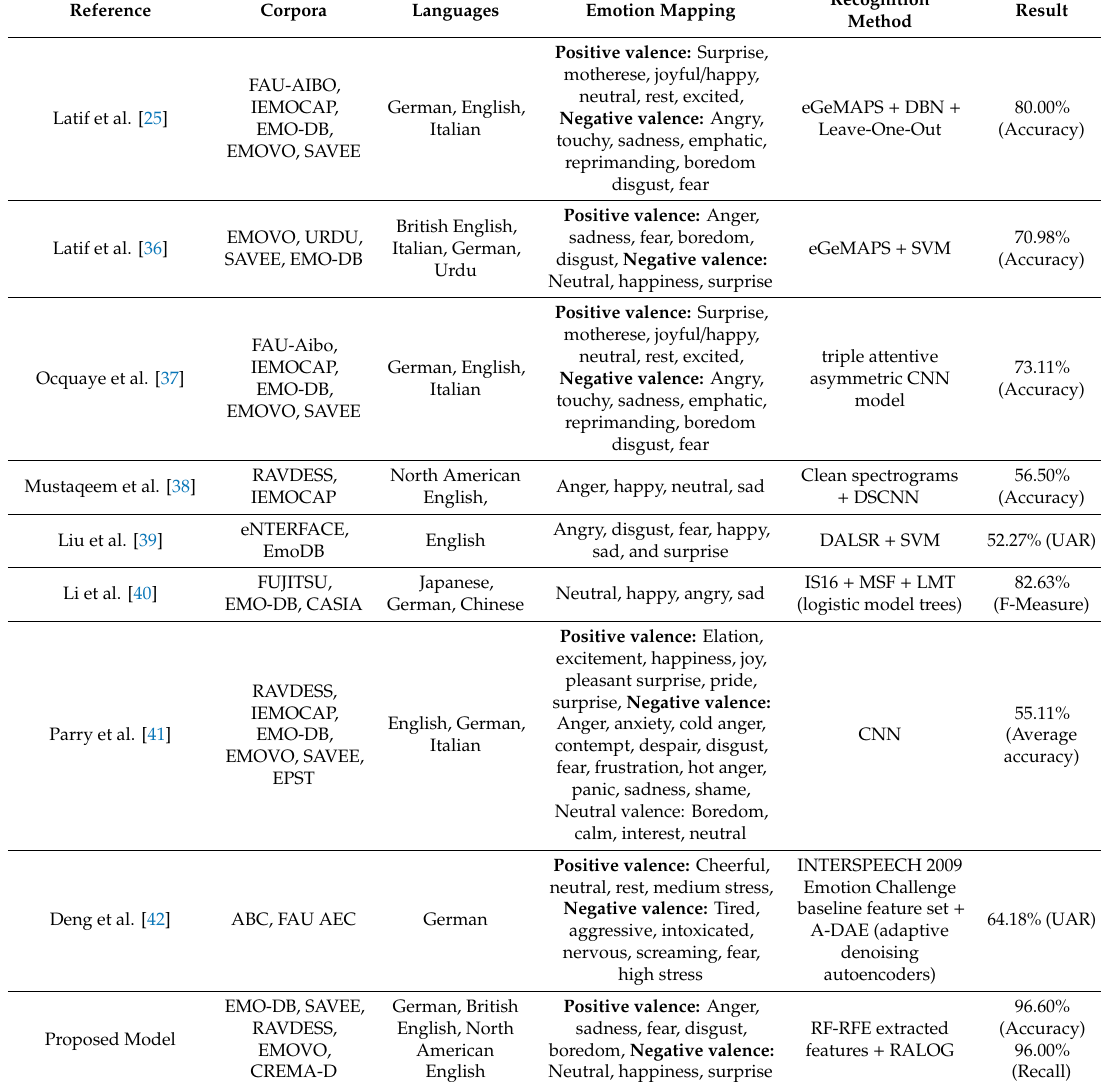
Table 1. Comparative analysis of our method with related